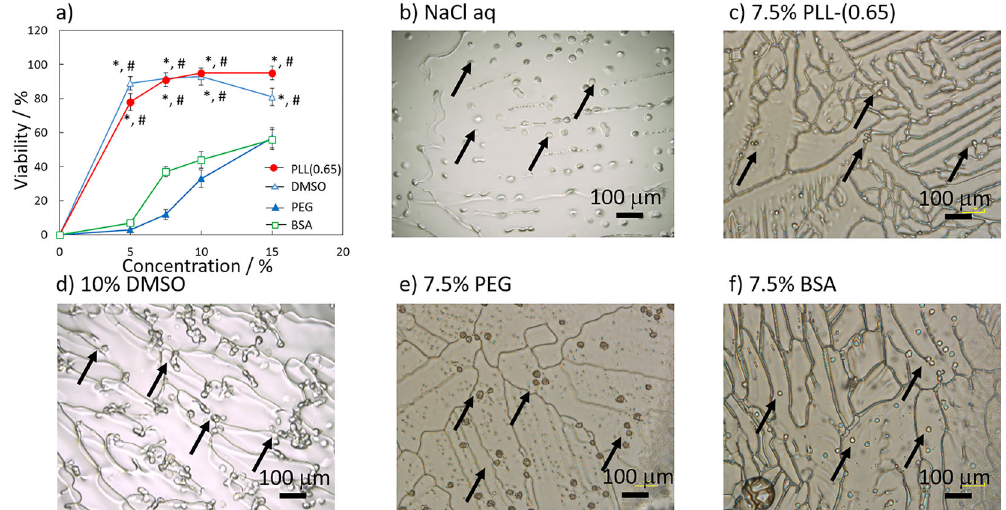
Fig. 1 Abilities of various CPAs to protect during cell freezing. a Cell viabilities after freezing with various CPAs. * p < 0.001 vs. PEG, # p < 0.001 vs. BSA. b – f Cryomicroscopy images at − 30 °C obtained by slow freezing ( − 1 °C/min) b without CPA and with c 7.5% PLL-(0.65), d 10% DMSO, e 7.5% PEG, and f 7.5% BSA. Arrows indicate representative cells during freezing. Scale bars: 100 µ